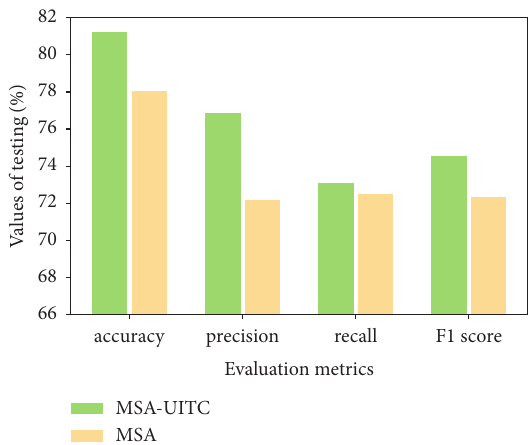
Figure 8: Performance comparison of MSA-UITC and MSA ar- chitecture on the HCR dataset.